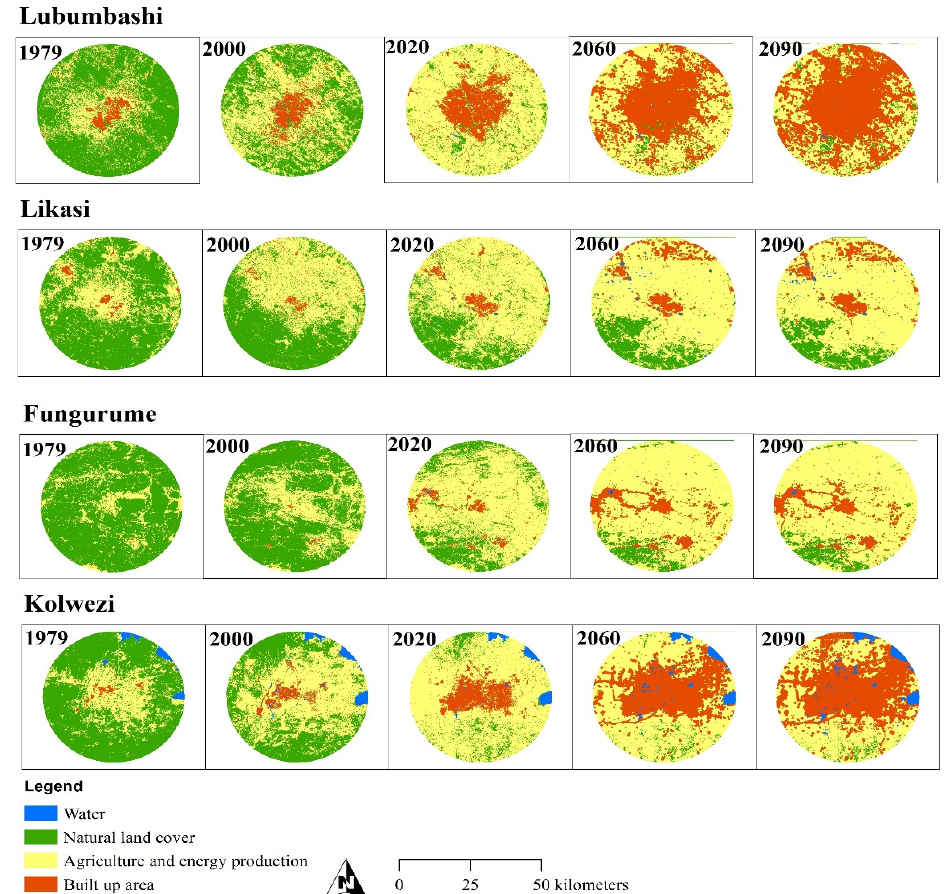
Figure 3. Land cover maps of Lubumbashi, Likasi, Fungurume and Kolwezi zones from the super- vised classification of Landsat images from 1979, 2000 and 2020 based on the maximum likelihood algorithm as well as the 2060 and 2090 maps from the 1st order Markov chain modelling. The dis- carded dates do not show much change compared to the nearby posted dates.